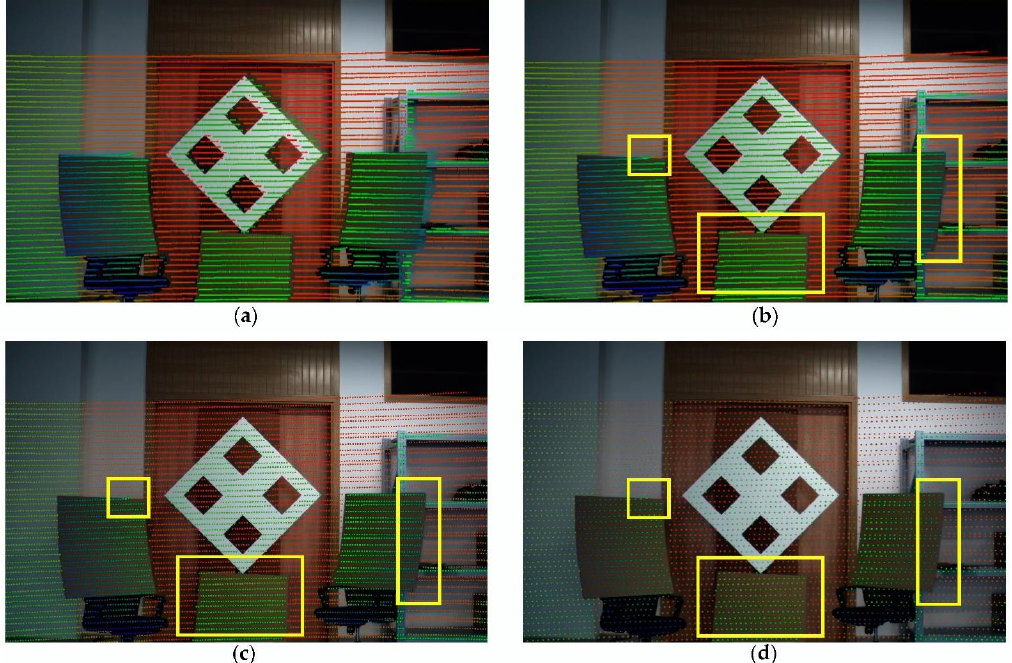
Figure 13. Results of indoor projection effect. ( a ) is projection in initial parameters, that is, calibration is not performed, ( b – d ) are the projection of θ which is equal to 0.1, 0.2, and 0.4, respectively. The contents in yellow rectangles can provide detailed reference.